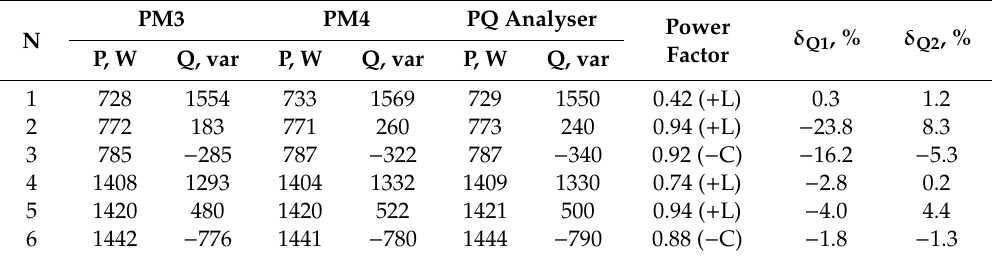
Table 5. Power consumption parameters at the test